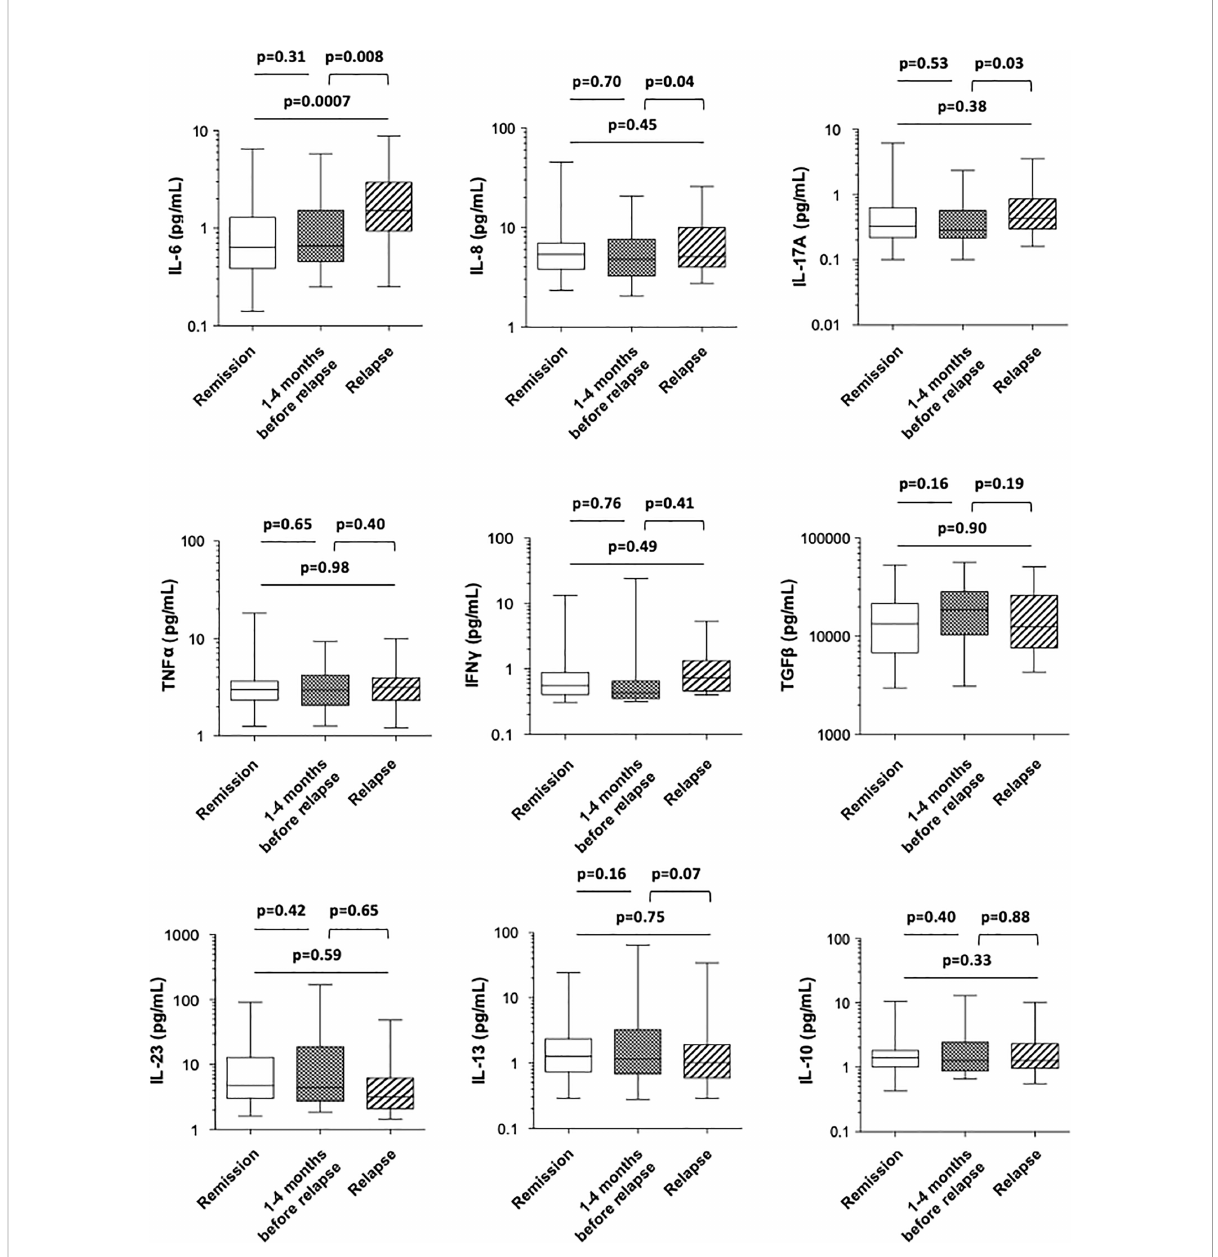
FIGURE 4 Comparison of the blood concentrations of various cytokines (IL-6, IL-8, IL-17A, TNF a , IFN g , TGF b , IL-23, IL-13, and IL-10) among Crohn ’ s disease patients who stayed in remission all throughout the follow-up (white), those who were in remission at the time of measurement but who experienced a relapse during the following 1 – 4 months (boxed) and at the time of relapse in patients who relapsed (shaded). The box plots show the median, upper, and lower quartiles of the data; the whiskers indicate the 95% con fi dence interval of the